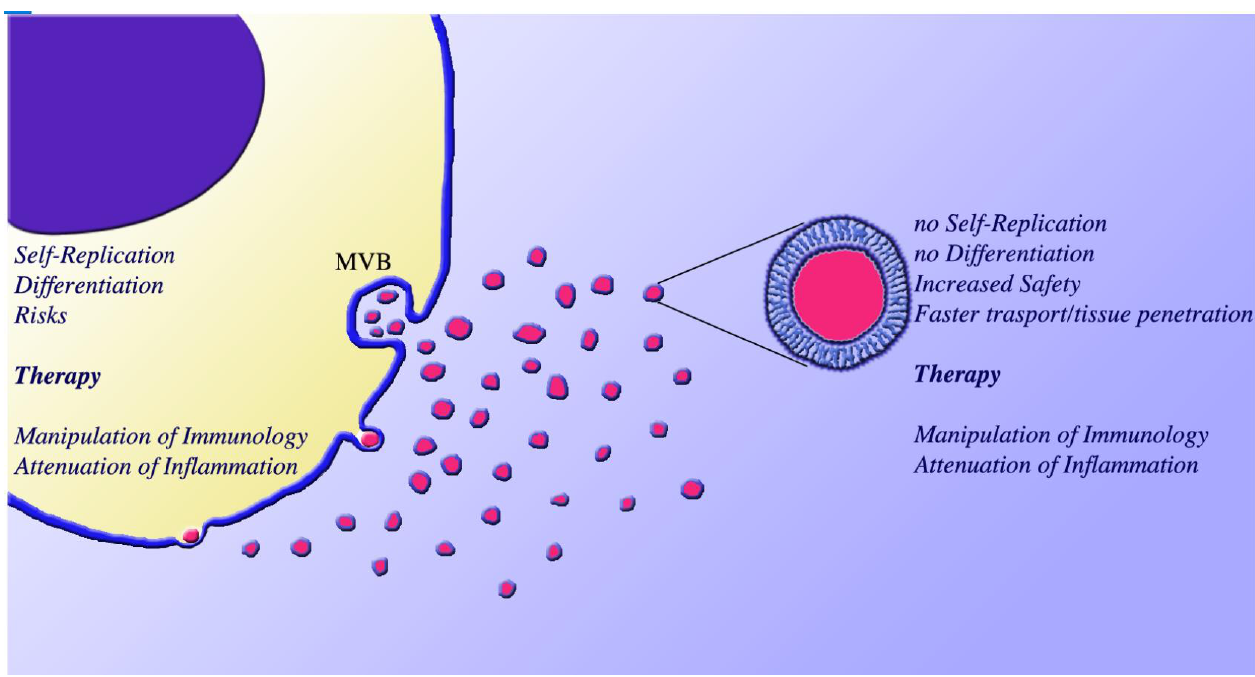
Figure 1. Comparison of MSC cells and their EVs. To the left an MSC cell illustrates its secretion of EVs. The small exosomes, generated and accumulated within endosomal vacuoles, the multi vesicular bodies (MVBs), are released upon exocytosis of the latter. The ectosomes, assembled in direct contact to the cytosolic surface of specialized rafts in the plasma membrane, undergo pinching off and then shedding to the extracellular space. A list of the MSC properties is shown to the left, over the cell cytoplasm (yellow). The first two, self-replication and differentiation, are typical of many types of cells active as MSCs. These two activities open the cells to many risks including cancers and immune rejections. The main property of MSCs is natural therapy against many diseases based, among others, on the properties of immunology manipulation and attenuation of inflammation. However, due to the dangers of accompanying risks, the therapeutic approach of MSCs in humans is limited to a few types of cells and diseases. The MSC-EVs, shown to the right, are the model of therapy alternative to MSCs. MSC-EVs recapitulate many properties analogous, and some time even better than those of the parental cells, including those in immunology and inflammation. Due to their different strategy, MSC-EVs do not express many properties related to the structure and function of their parental cells. In fact, they show no replication, no differentiation and no few other properties. Increased safety in the extracellular space, faster transport and good tissue penetration are advantages of MSC-EVs, especially when administered in vivo. Finally, the MSC-EVs are more appropriate for GOP engineering (see Section 5-Diseases: Mechanisms of Protection by MSC-EV). The ensuing, technical therapy can be combined to the natural forms expressed by the vesicles. The properties of MSC-EVs, illustrated here, together with others reported and discussed in this review, explain the extraordinary success of the intense studies dedicated to these vesicles, especially those about therapy.